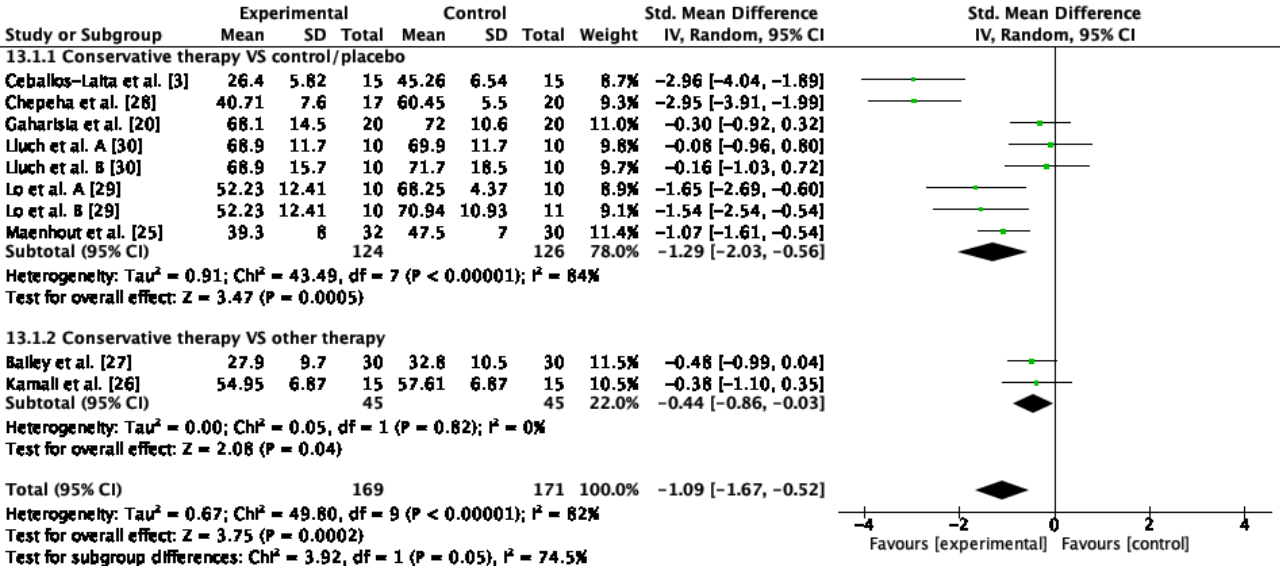
Figure 4. Forest plot of external rotation ROM for conservative therapy versus control/sham and combination of conservative therapies versus conventional therapy in isolation. Lluch et al. A. com- pared manual therapy versus control intervention. Lluch et al. B compared the manual contact